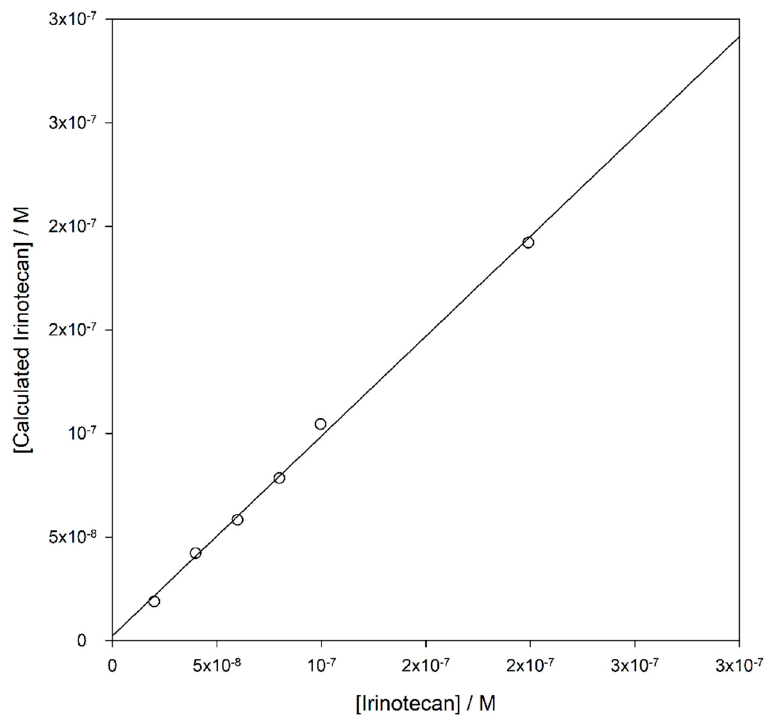
Figure 7. Correlation between the concentration of irinotecan in plasma samples and the calculated values from Equation (3).